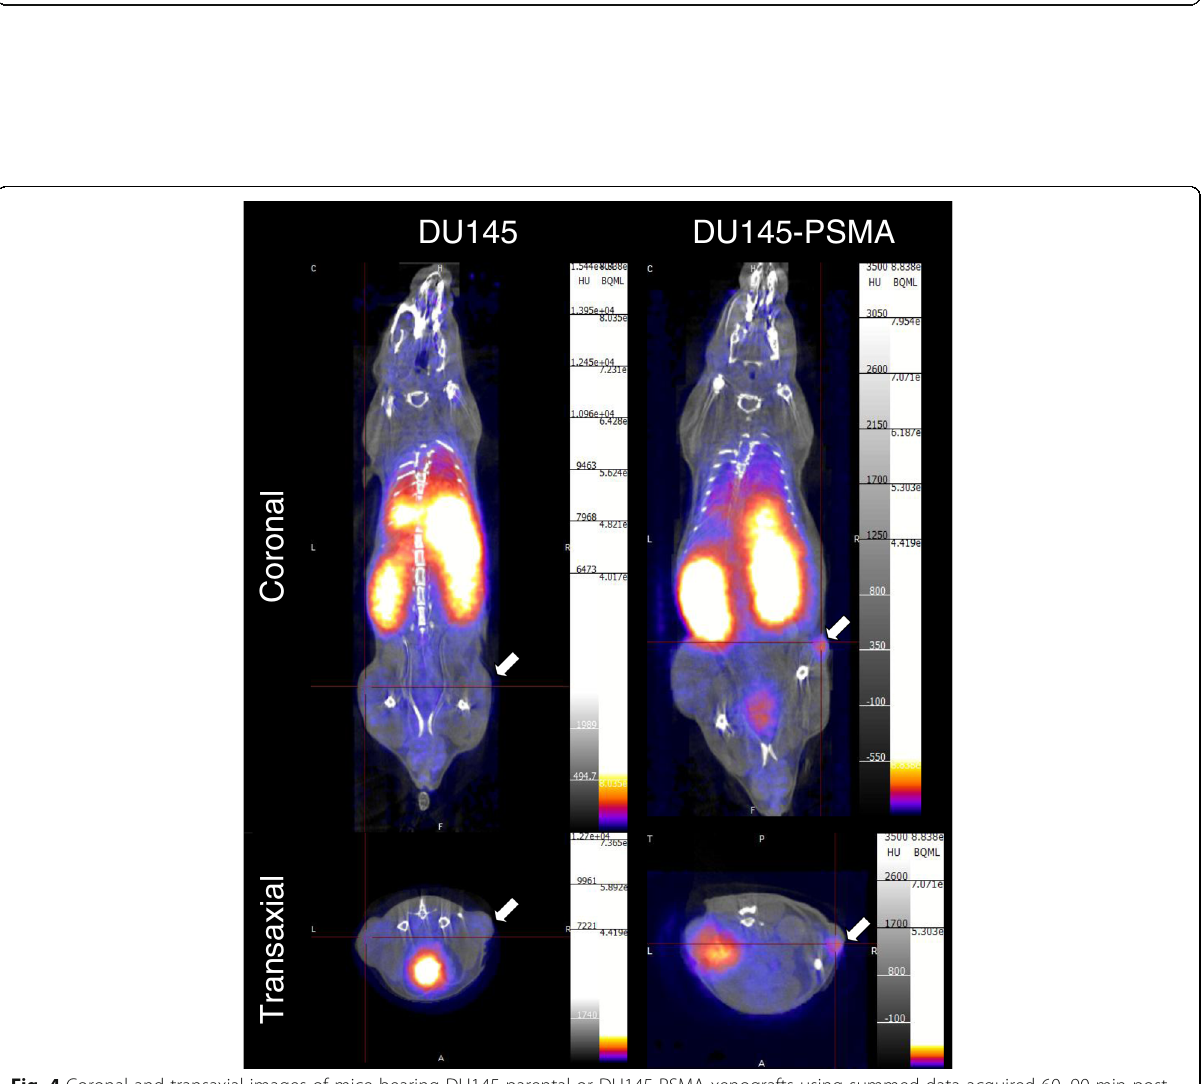
Fig. 4 Coronal and transaxial images of mice bearing DU145 parental or DU145-PSMA xenografts using summed data acquired 60 – 90 min post- injection of 7 MBq (10 μ g) 68 Ga-THP-mal-J591c-scFv. Arrows mark location of xenograft